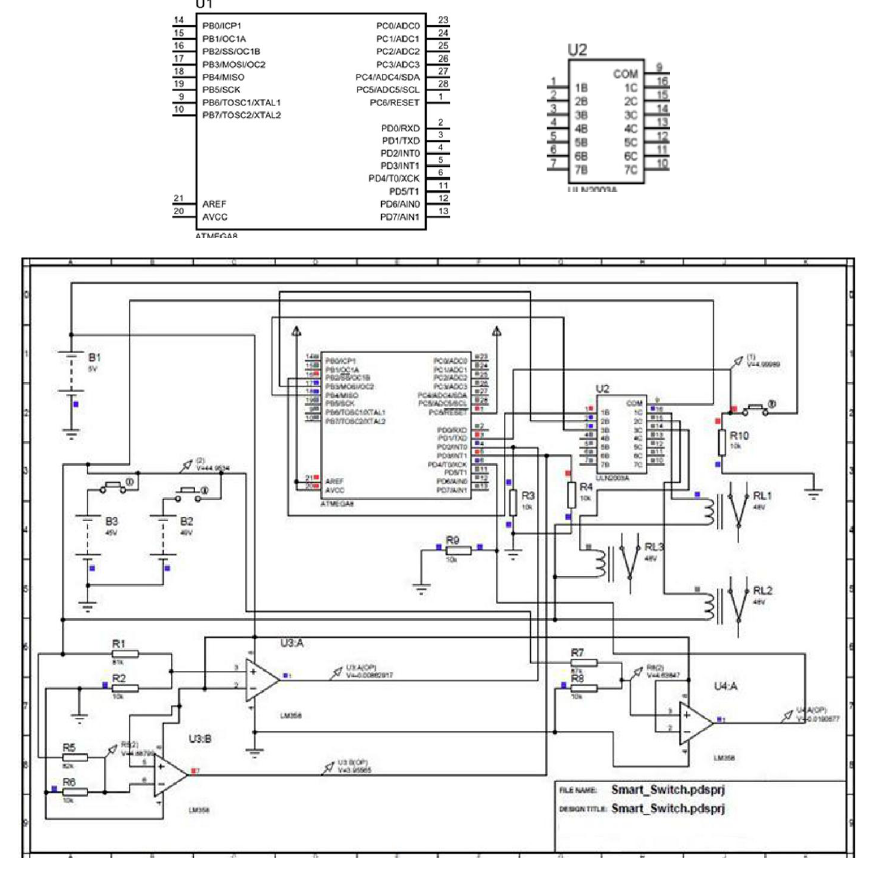
FIG. 4. CO-SIMULATION OF MICROCONTROLLER BASED SMART SWITCH CIRCUIT DIAGRAM TABLE 1. PRESENT FUEL CONSUMPTION DATA DG SET CAPACITY Existing Position (Auto Start)